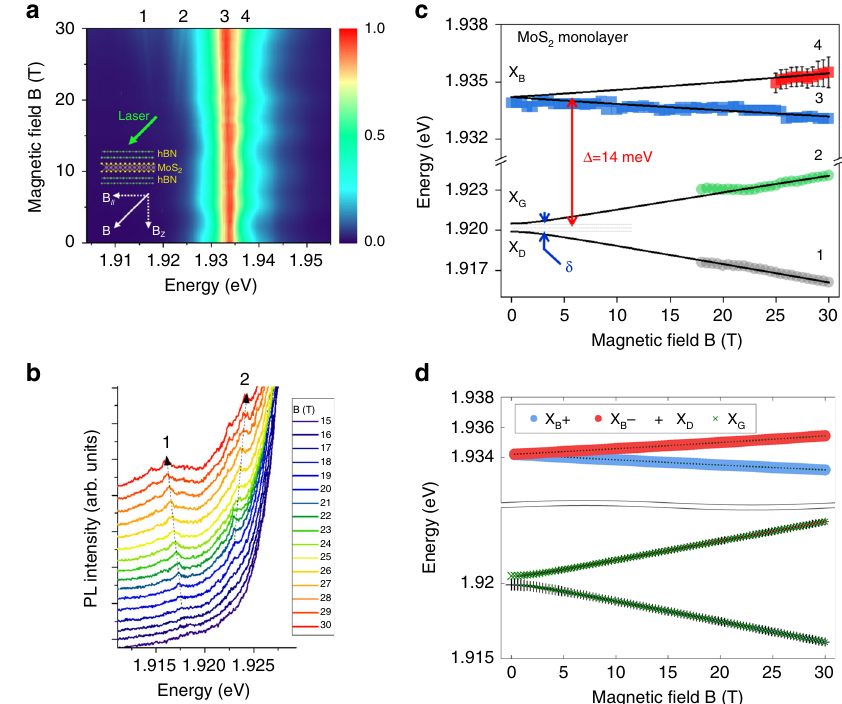
Fig. 4 Tilted (45°) magnetic fi eld — the four mixed excitons states (labeled 1, 2, 3, 4) in MoS 2 monolayer revealed by magneto-photoluminescence. a Color map of the variation of the PL intensity as a function of B; b PL spectra for magnetic fi elds from 15 to 30 T showing the emergence of the two lowest energy states 1 and 2 (mainly with gray and dark components). c Magnetic fi eld dependence of the energy of the four mixed exciton states. The full lines are fi ts to the model described in the text. The notations dark exciton (X D ), gray exciton (X G ) and bright excitons (X B ) are only strictly valid at 0 T. d Same fi tting results than in c . The size of each symbol is proportional to the weight of each component (the two bright component X component X G and X D ) (see Supplementary Note 7 for the calculation of the weight of the four components at high fi